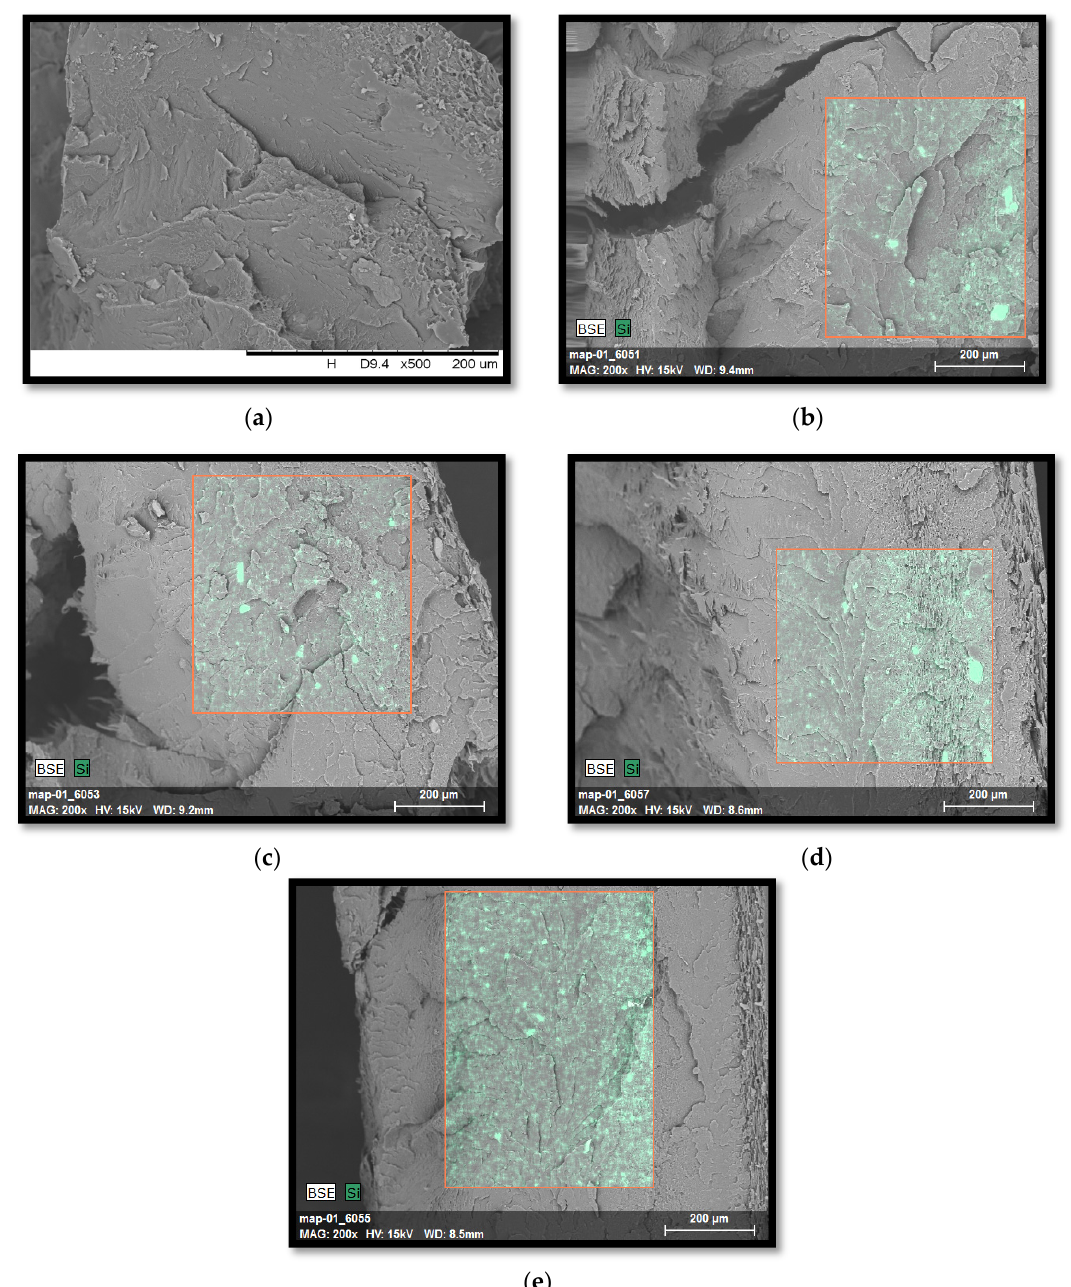
Figure 6. SEM micrographs with an EDS attachment of PS polymer and composites based on PS: ( a ) PS, ( b ) PS/3%S, ( c ) PS/3%B, ( d ) PS/3%L, ( e ) PS/1.5%L/1.5%B.